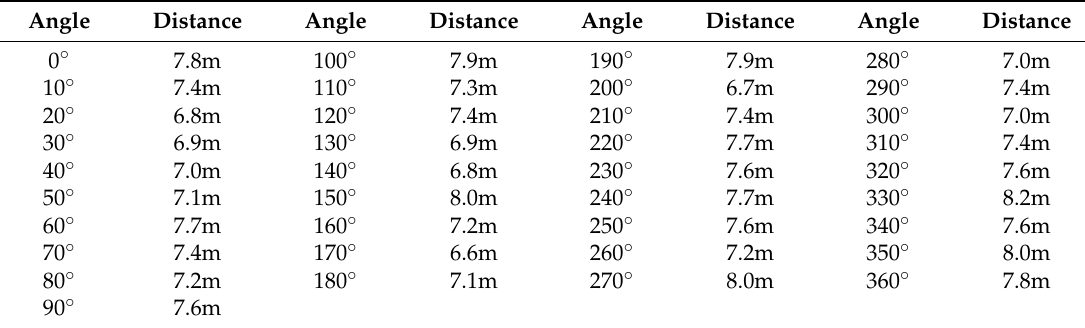
Table 10. Real distance of PPU detection by UMCU (dynamic